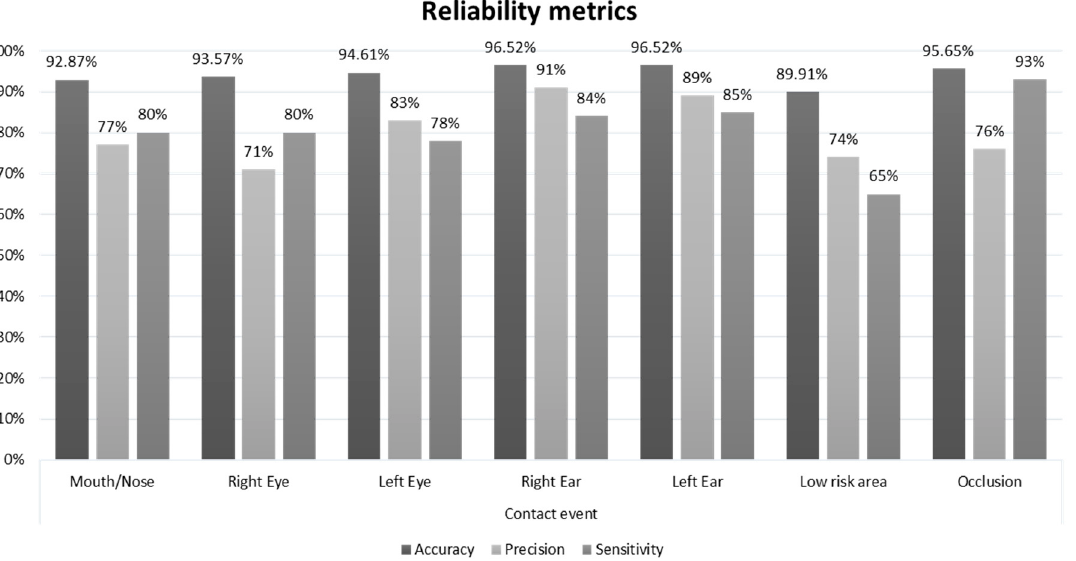
Figure 7. The reliability metrics assessed for each class of the seven-class classification.